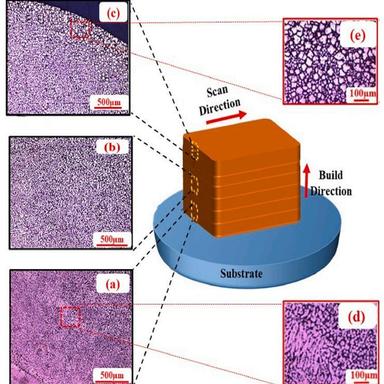
Microstructure of LDED deposited Cu along build direction.